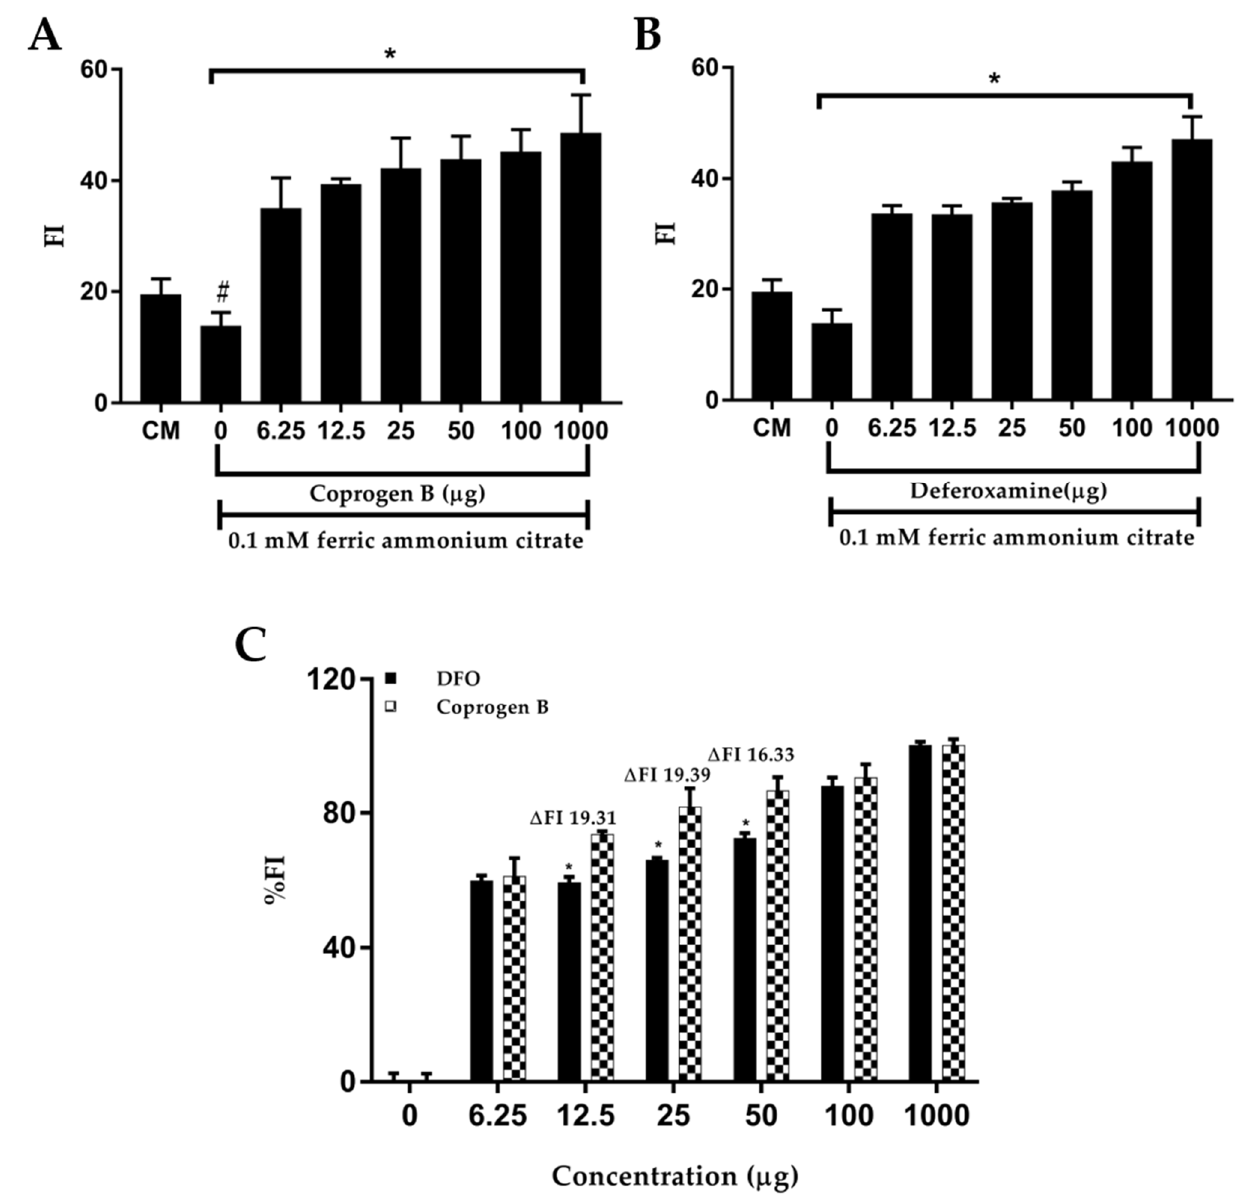
Figure 10. Evaluation of the ability of coprogen B and deferoxamine to reduce labile iron pool (LIP) levels in iron-loaded human hepatocellular carcinoma (Huh7) cells. The calcein fluorescent intensity was detected by a microplate reader (excitation wavelength at 495 nm and emission wavelength at 515 nm). Elevation of fluorescence intensity (FI) showing the reduction of the LIP is a consequence of the intracellular binding of ferric iron by coprogen B ( A ) and deferoxamine (DFO) ( B ). Comparison between percentage fluorescence intensity (%FI) of DFO or coprogen B treated iron overloaded Huh7 cells at various concentrations ( C ). The data show more effective binding of coprogen B than DFO at 12.5 to 50 µg. ∆FI is the different percentage fluorescent intensity. Data obtained from three independent triplicate experiments are expressed as mean ± SD, # p < 0.05 when compared with culture medium (control); * p < 0.05 when compared with ferric ammonium citrate (FAC) treatment alone.